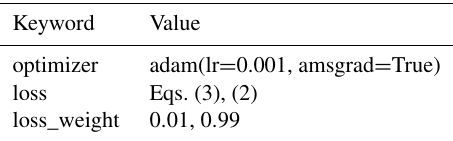
Table A3. Specific compile options passed to Keras’ compile method. Other keywords which are not listed in this table are left with default values.